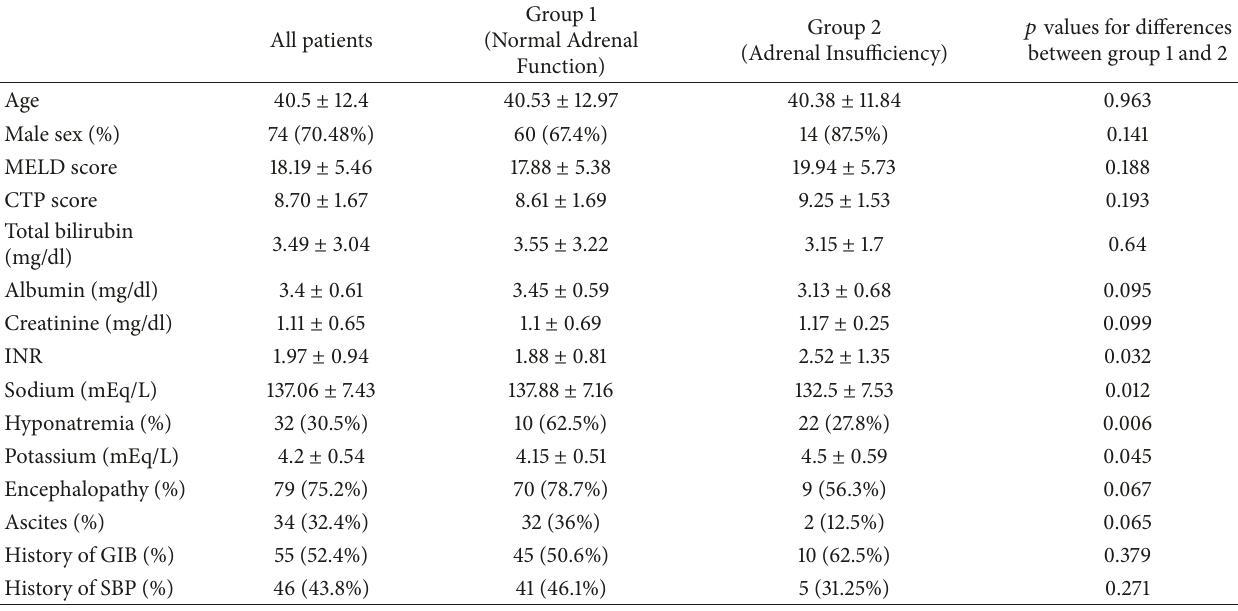
Table 1: Demographic data and clinical characteristics of all patients, patients with normal adrenal function (group 1) and adrenal insufficiency (group